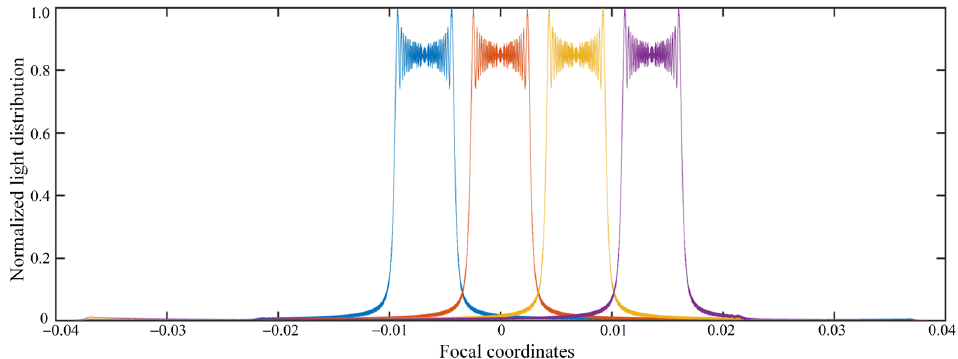
Figure 11. Normalized light distribution for the four perspectives.